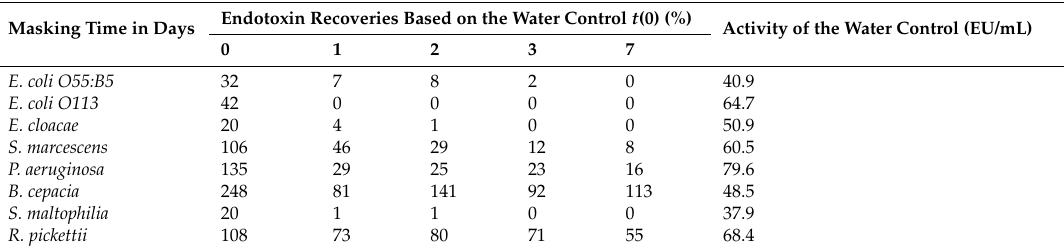
Table 2. Hold time study using naturally occurring endotoxins (NOEs) from different species. The hold time study was performed over 7 days using the prepared NOEs for different species. All recoveries in percentage were calculated based on the water control at t